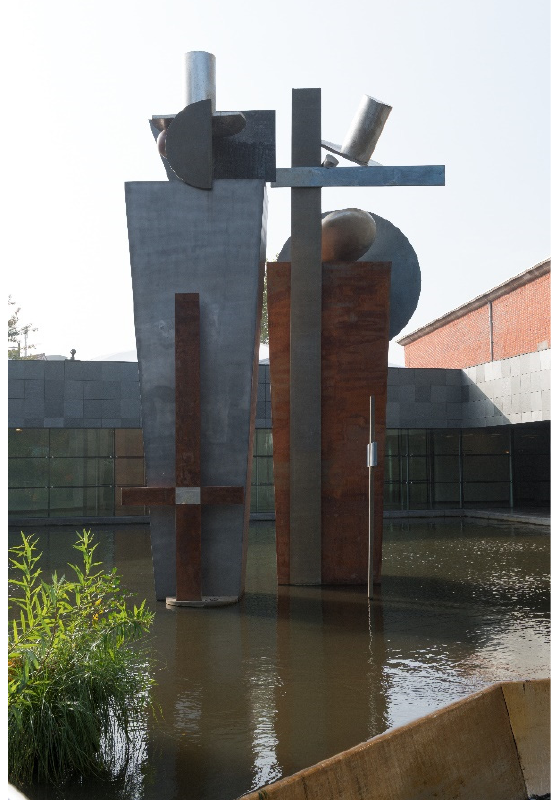
Figure 21. Statue after El Lissitzky, ‘The Gravediggers’, construction designed by Henry Milner, 2009. Museum Danubiana, Bratislava. Photo: Peter Cox.